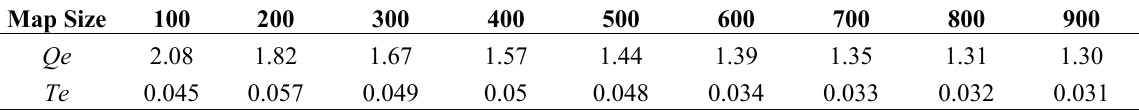
Table 1. Map quality measures at different map sizes of the trained